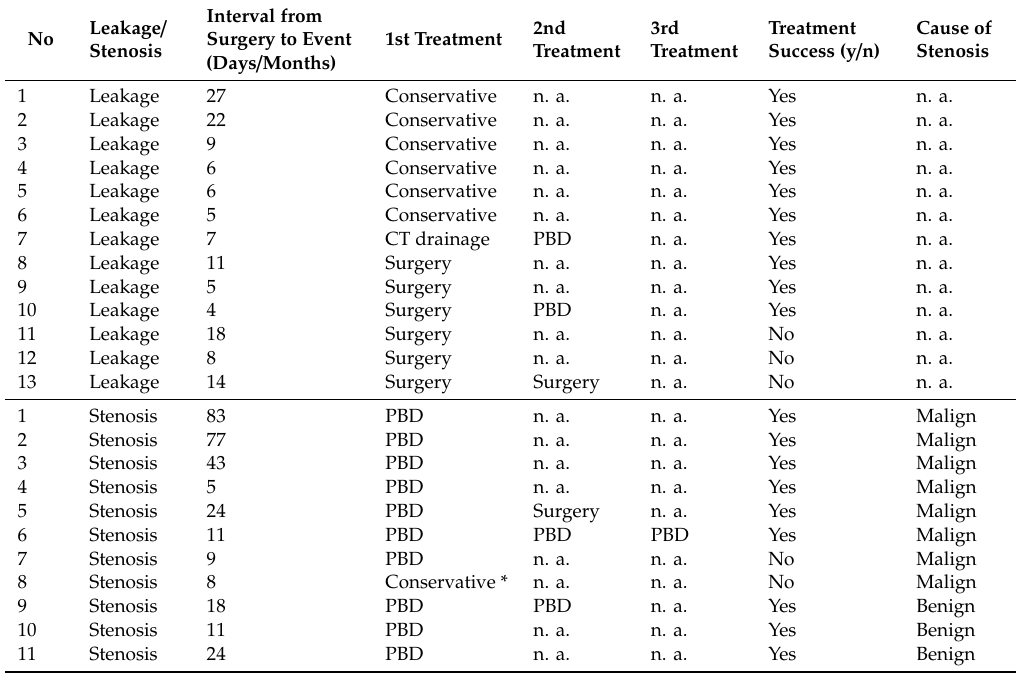
Table 2. Specific treatment and treatment success in postoperative anastomotic leakage or stenosis of hepaticojejunostomies.